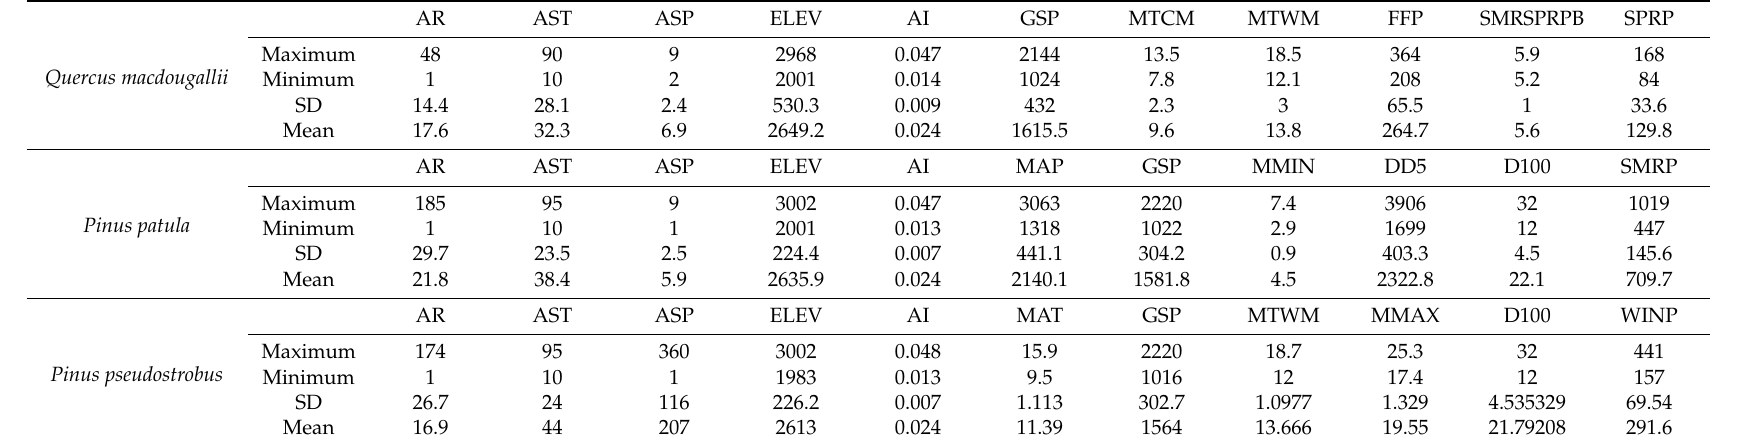
Table 1. Descriptive statistics of the variables used in this